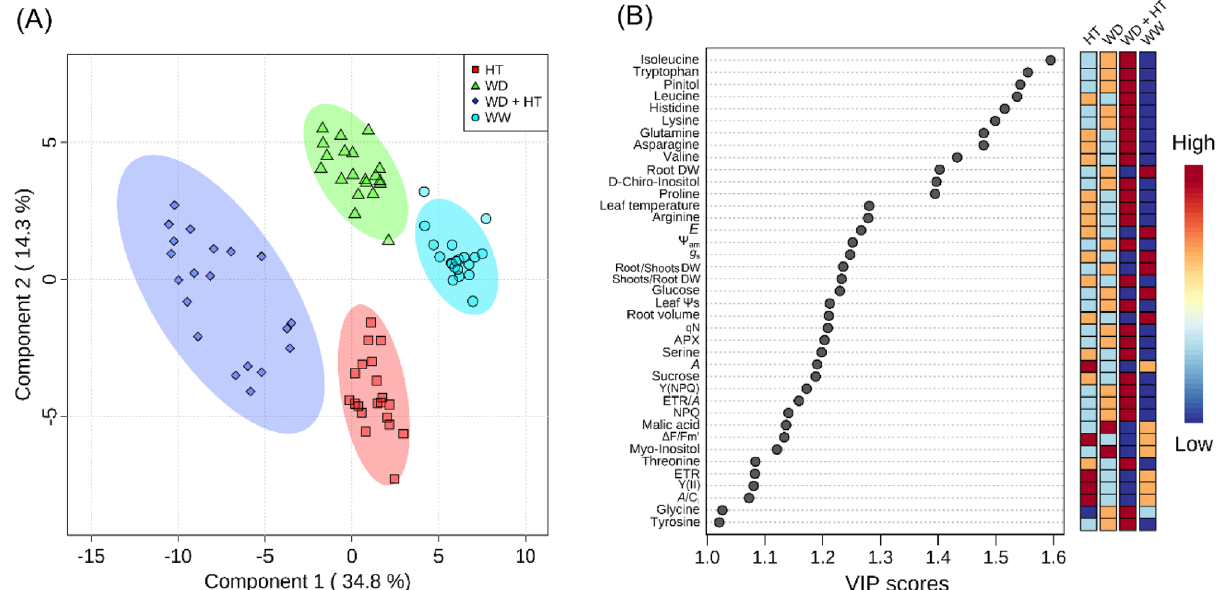
Figure 7. Multivariate analysis combining all data of soybean plants maintained for 8 days under well-watered (WW; 100% holding water capacity HWC, 25 °C), water deficit (WD; 40% HWC, 25 °C), high temperature (HT; 100% HWC, 40 °C) and water deficit plus high temperature (WD + HT; 40% HWC; 40 °C) conditions. ( A ) Partial least square-discriminant analysis (PLS-DA). ( B ) Variable importance in projection (VIP) scores of the PLS-DA model. Metabolites included in the VIP score lists have a score higher than 1, which indicates those that mostly contributed to the separation observed at the PLS-DA model of the respective cultivar. PLS-DA was carried out by combining data from all genotypes. The data were normalized by using Log and Auto-scaling transformations on the MetaboAnalyst platform 98 ( n =